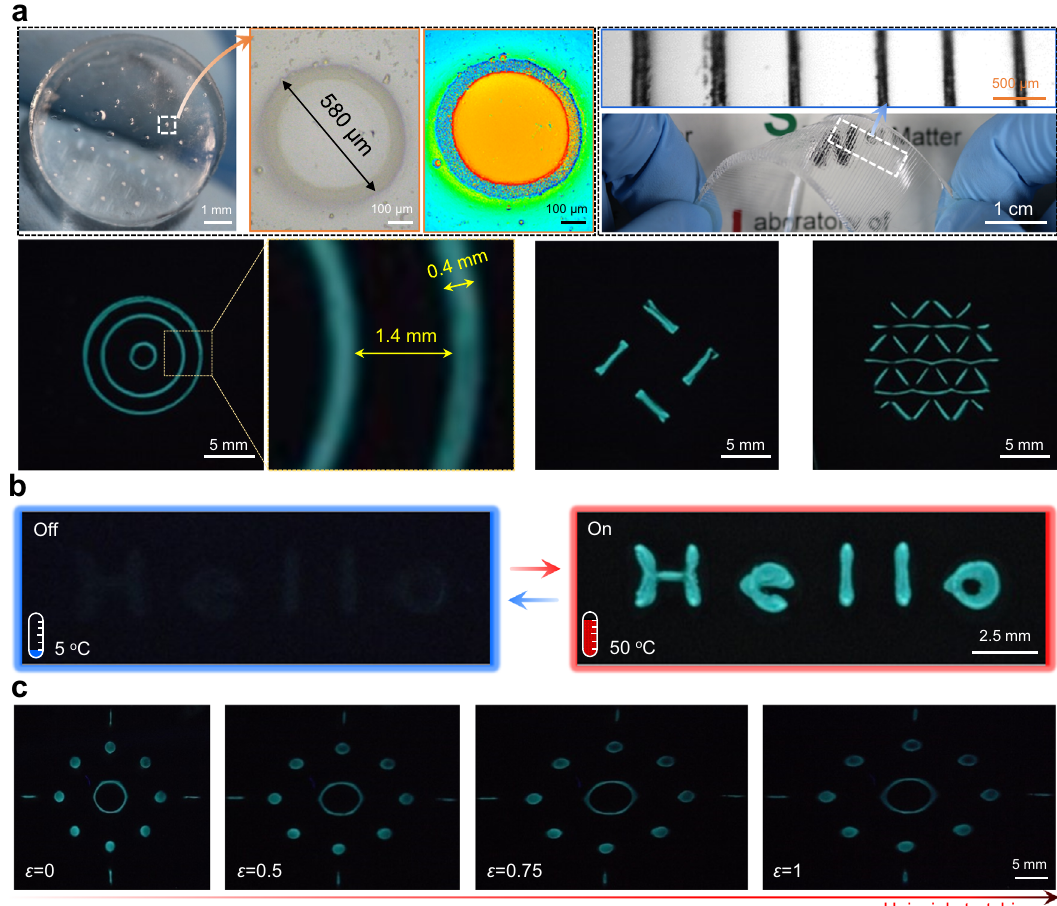
Fig. 4 | Programmable microstructures growth on hydrogel surfaces. a Optical and fl uorescence images showing various complex structures on DN hydrogel surfacesformedbysurfaceforce-triggeredgrowth. b Fluorescenceimagestoshow